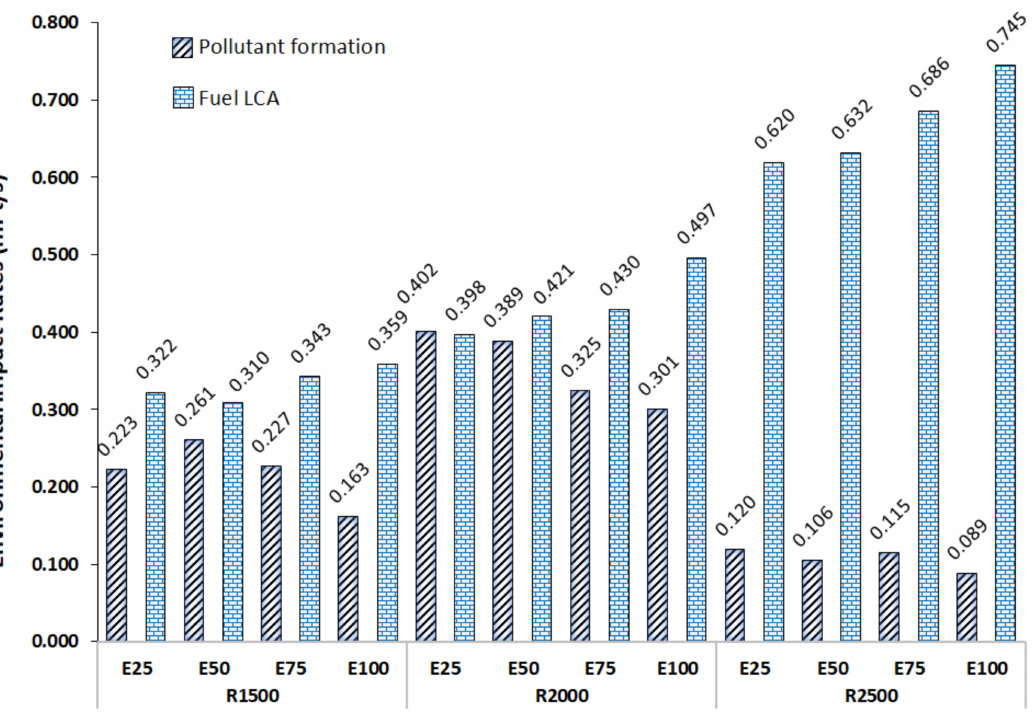
Figure 4. Environmental impact of brake power per exergy unit vs. ethanol contents and engine speeds.